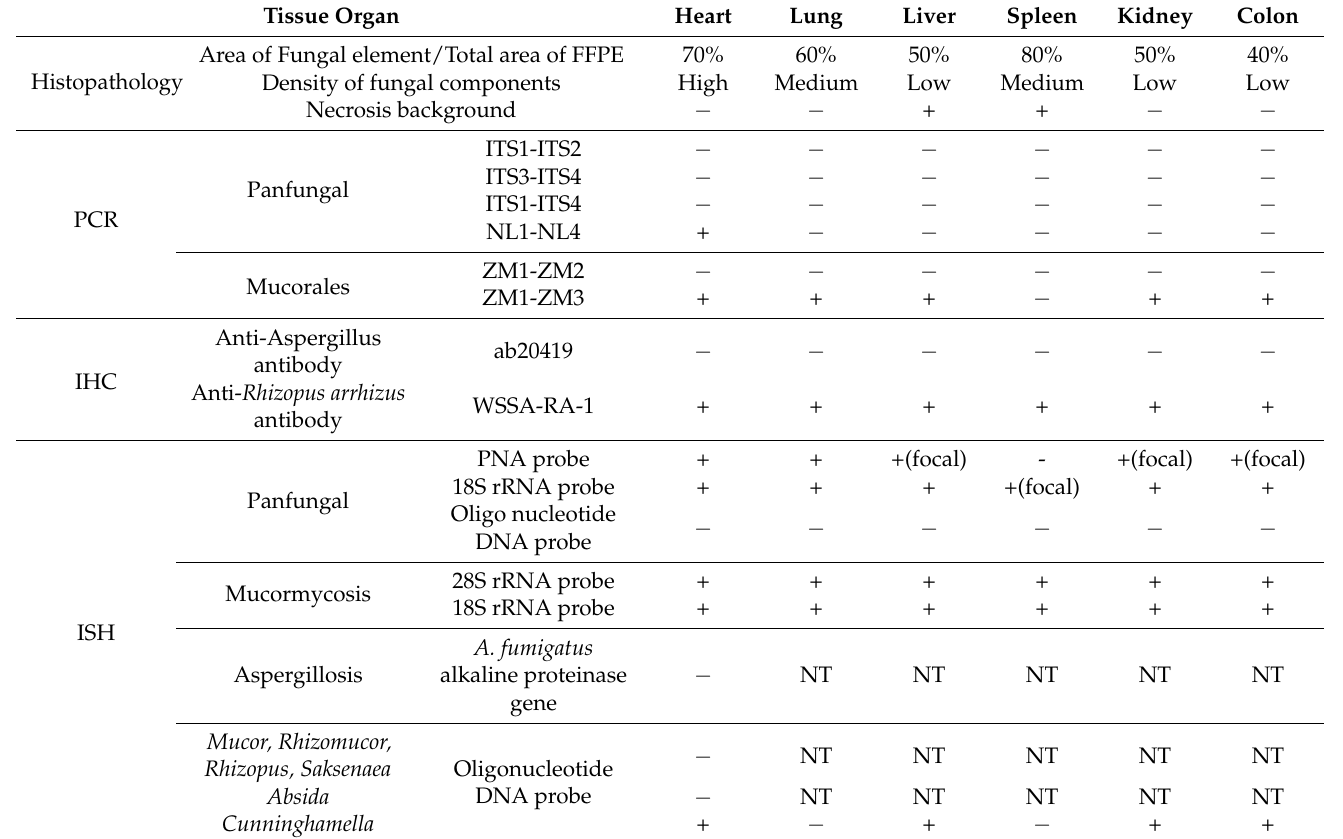
Table 1. The histopathological evaluation of each tissue organ and PCR, IHC, and ISH results. Tissue Organ Heart Lung Liver